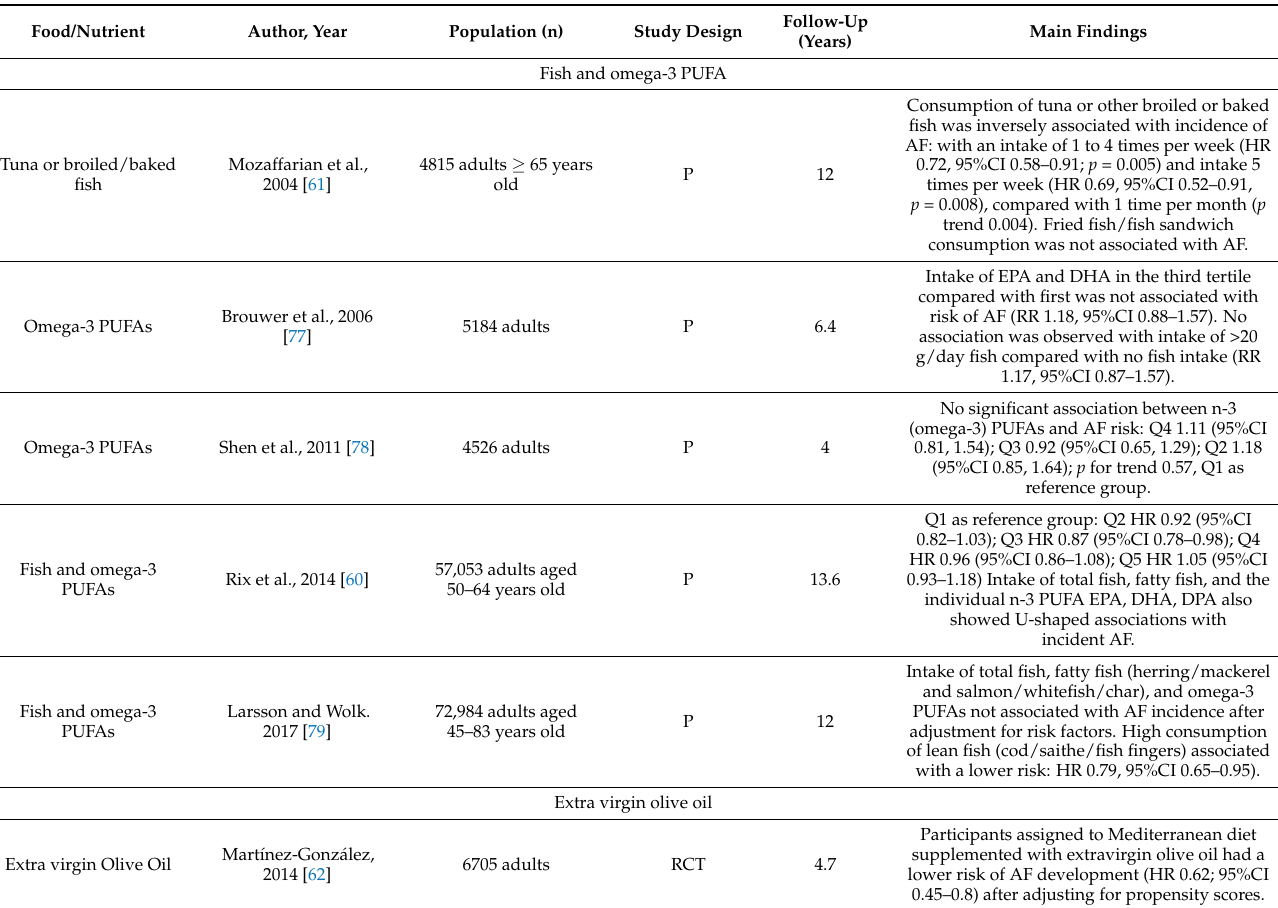
Table 2. Prospective studies and randomize controlled trials exploring the association between single foods/nutrients and incident atrial